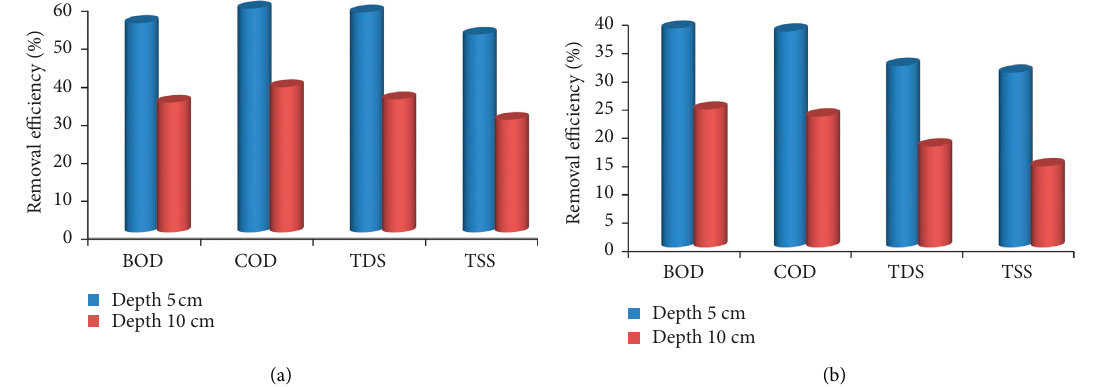
Figure 8: Effect of (a) Coir filter media density and (b) Areca Husk filter media density for the treatment of wastewater.